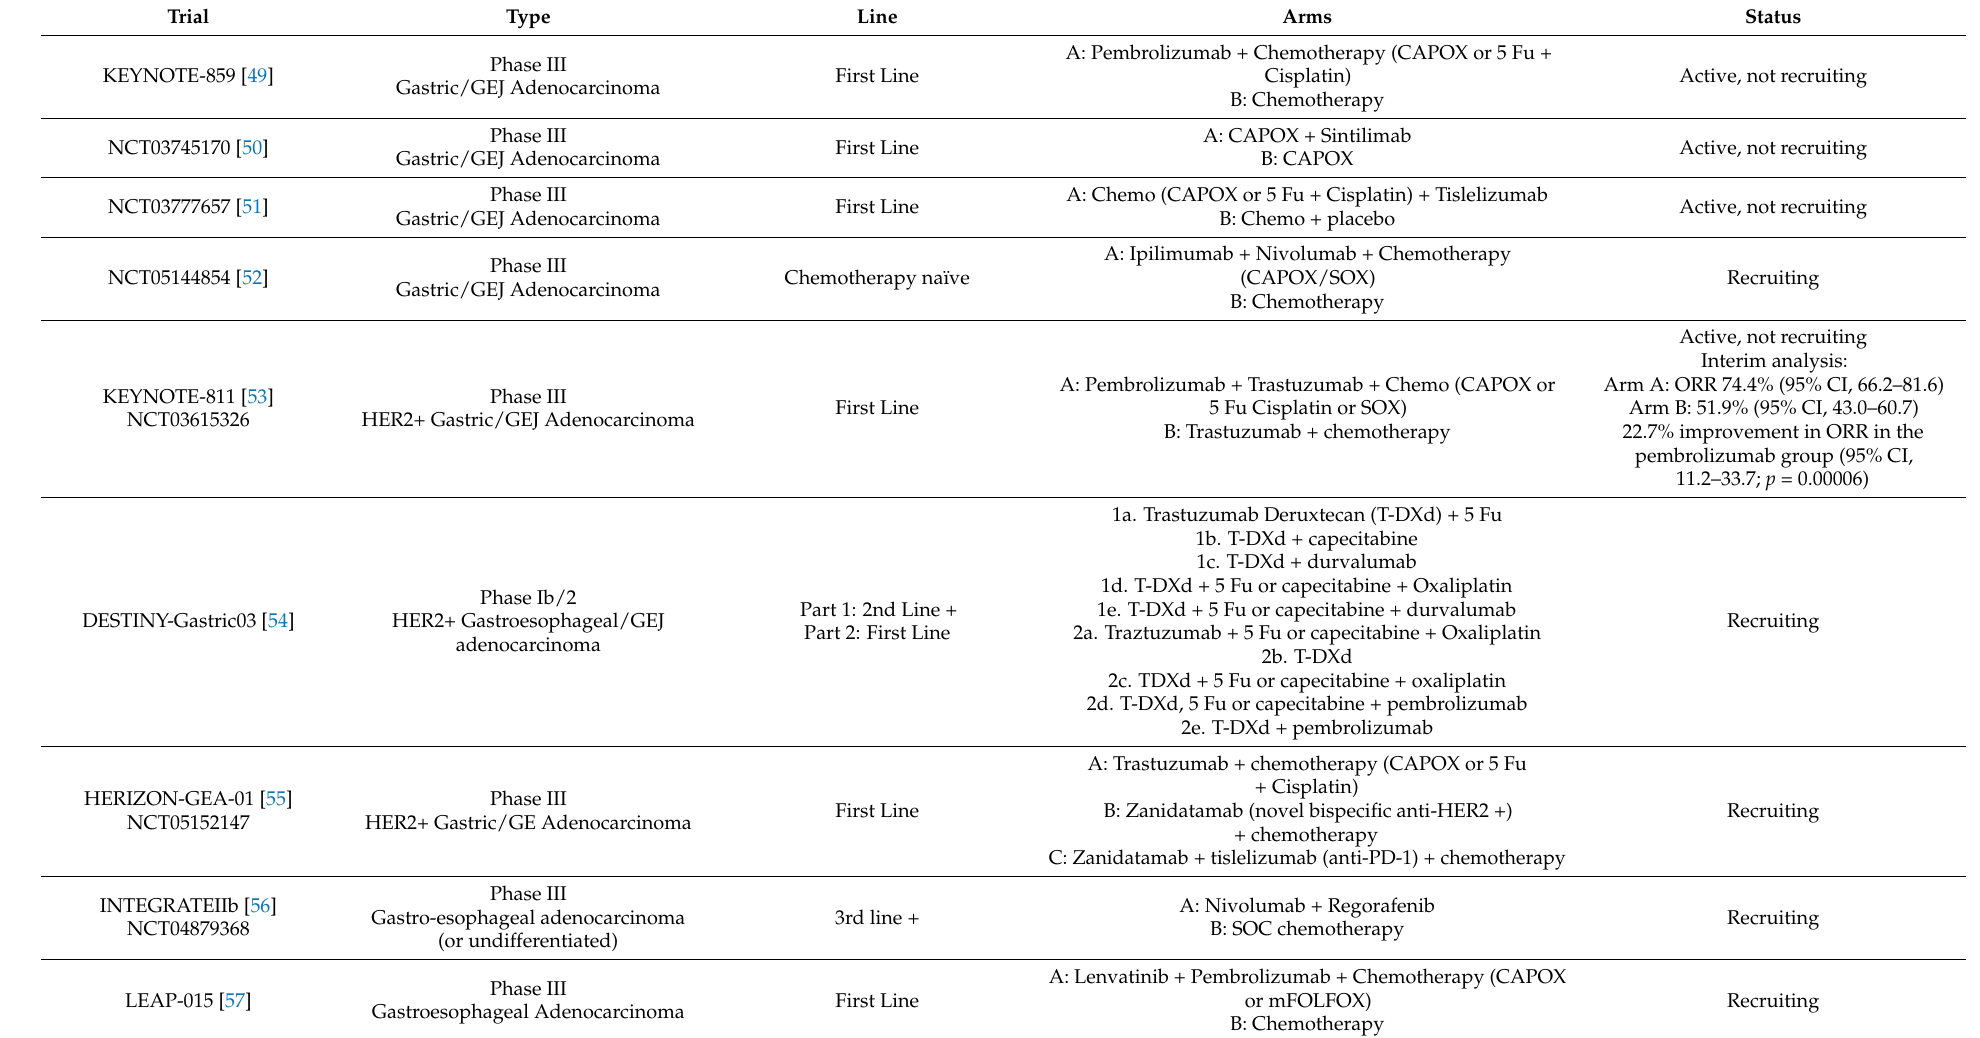
Table 3. Summary of ongoing clinical trials with immune checkpoint inhibitors in the advanced esophagogastric adenocarcinoma